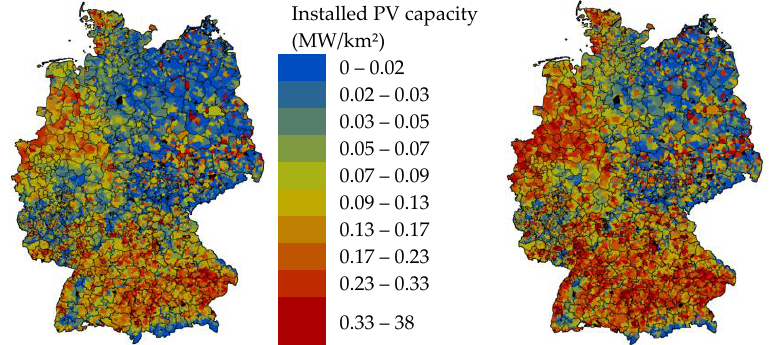
Figure 4. Installed PV capacity on municipalities level in Germany by 2014 (Input Data from EnergyMap [39]), totalling 39.4 GW ( left ); and installed PV capacity on the municipalities level by 2050, which totals 55 GW ( right ).